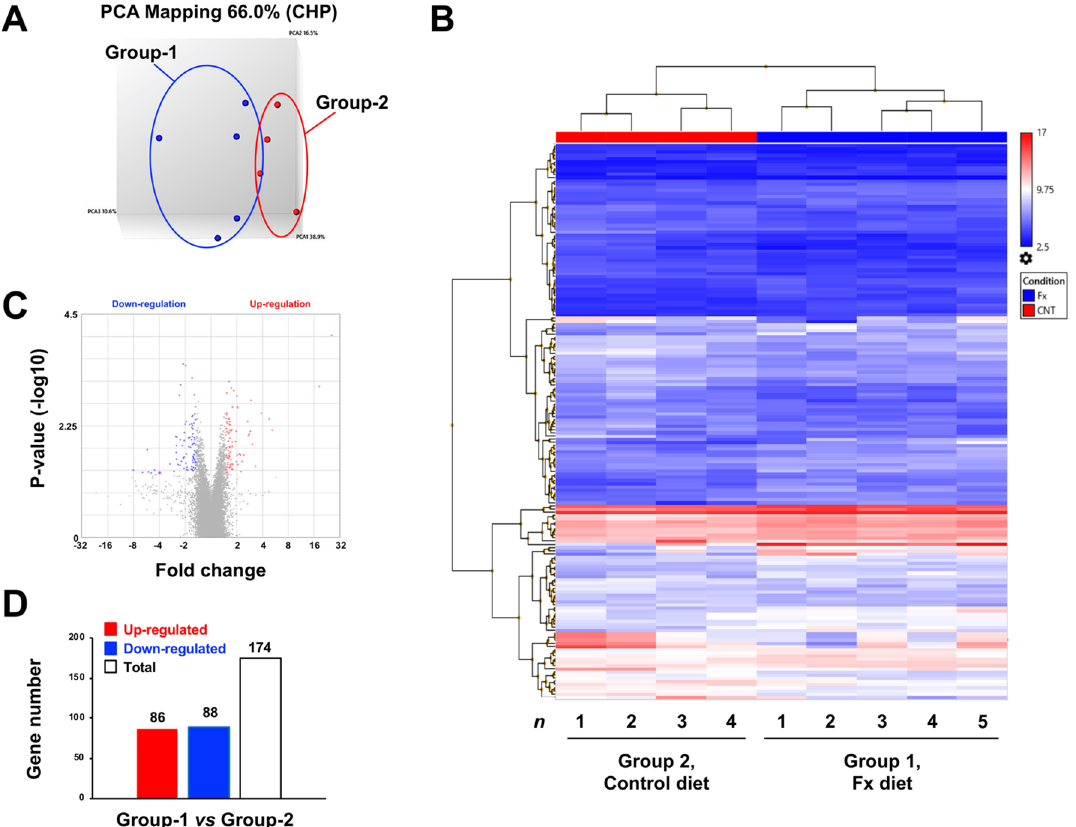
Figure 5. Gene expression profiles in pancreatic cancer model mice with or without fucoxanthin (Fx) administration. Gene expression levels between the Fx-treated (group 1) and control (group 2) mice were subjected to Clariom TM S mouse assays and TAC software ( n = 4–5). ( A ) PCoA plots on gene set distance between groups 1 and 2. ( B ) Hierarchical clustering analysis for 174 genes between groups 1 and 2. ( C ) Volcano plots between groups 1 and 2. ( D ) Total number of up- ( ≥ 1.5-fold) and downregulated ( ≤− 1.5-fold) genes between groups 1 and